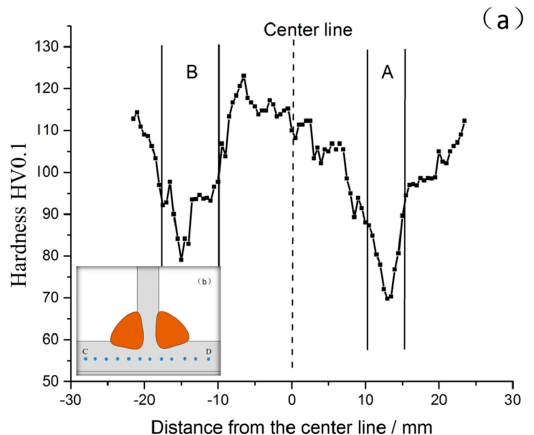
Figure 6. Hardness distribution of T-type joints on the cross plate: ( a ) T-type joint transverse hardness; and, ( b ) T-type transverse-point joint hardness test.